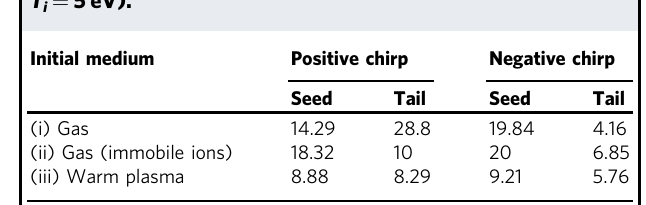
Fig. 2 1D simulation results. a , b are seed fi eld envelopes after an interaction, for positively and negatively chirped pump pulses, respectively. The back- scattering produced in advance of the seed pulse is shown in orange, the ampli fi ed seed pulse in purple, and the scattered light trailing the seed pulse in green. Inset I shows the initial seed envelope. Insets II, III display the ampli fi ed seed pulses (purple region) on a magni fi ed scale. c , d present the spectra obtained from a and b , respectively. The colour scheme associates spectra with temporal segments. The dotted black curve represents the initial seed spectrum. All spectra are normalised to the same value. e , f are the electron density spectra for positive and negative frequency chirp, respectively. Spectra are calculated at the time the seed pulse exits the plasma (seed propagates from top to bottom). The wave numbers are given in units of approximately the inverse beat wavelength, 2/ λ 0 = 1/400 nm − 1 . g , h are similar to e and f , but correspond to the ion density spectra. The electron density spectral amplitudes have been multiplied by factor four to be visible on the same scale as the ion density spectra. In f and h no spectral signature of the grating is visible when presented on the same scale as e and g Table 1 Gain values. Scattered energy normalised to the initial seed energy obtained from the 1D simulations with different con fi gurations: (i) Gas (atomic hydrogen, with mobile electrons and ions — corresponds to the main simulation results presented in this paper); (ii) Gas with immobile ions after ionisation; (iii) Warm plasma comprising pre-ionised hydrogen with an electron temperature, T e = 50 eV, and an ion temperature, T = 5 eV). i